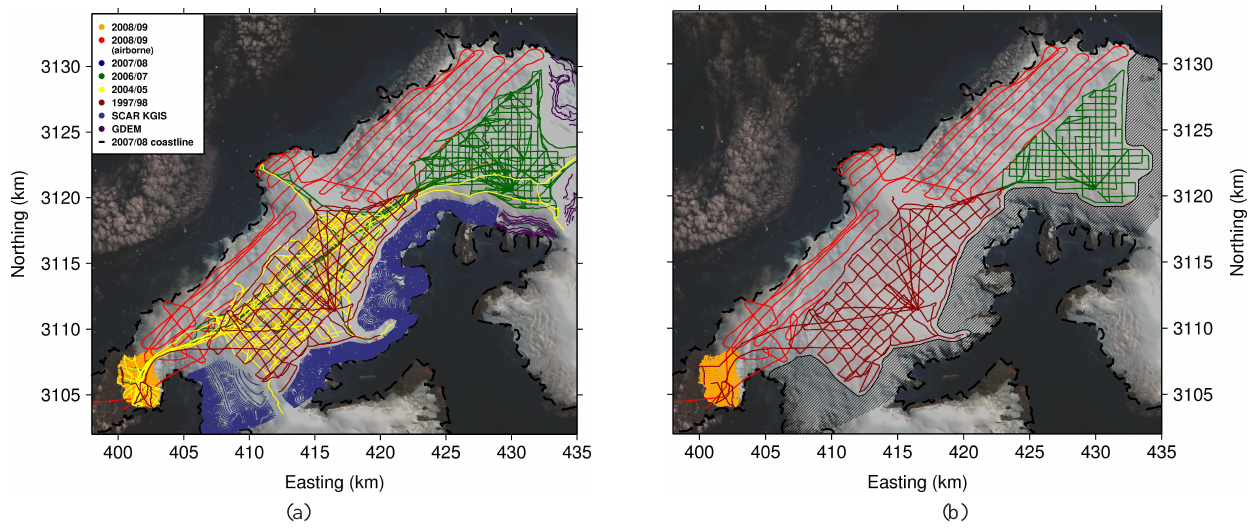
Figure 2. Spatial distribution and temporal coverage of the (a) DGPS and (b) GPR profiles in the various campaigns and additional data sets. The shaded area indicates where the DEM’s are based on extrapolation. Background image is a © SPOT Image from 2000.